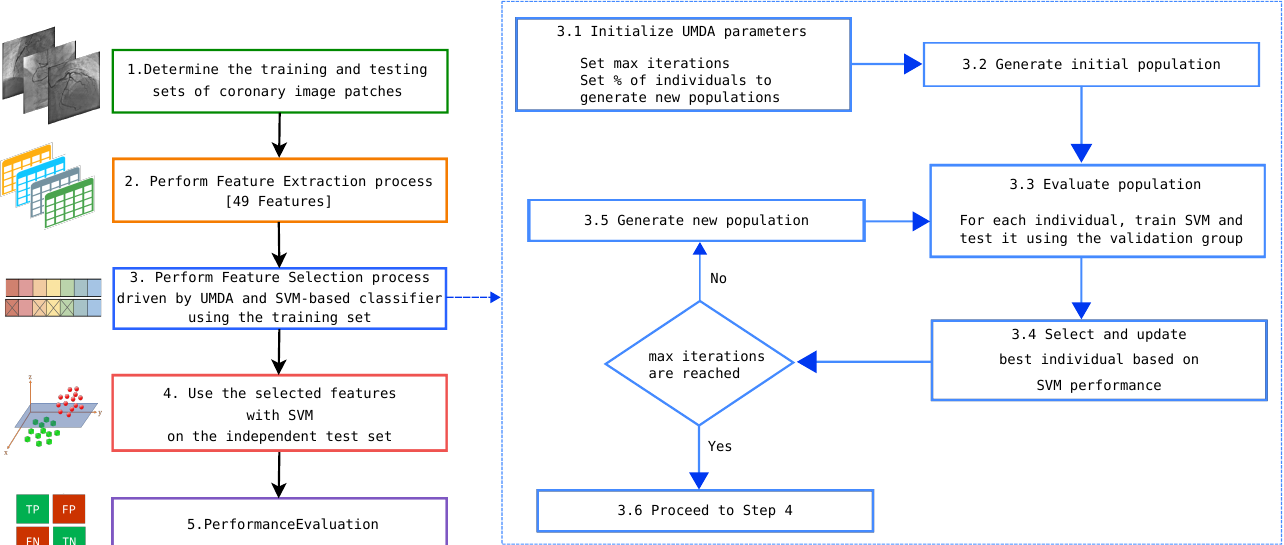
Figure 3. Flowchart of the proposed method for the automatic classification of coronary